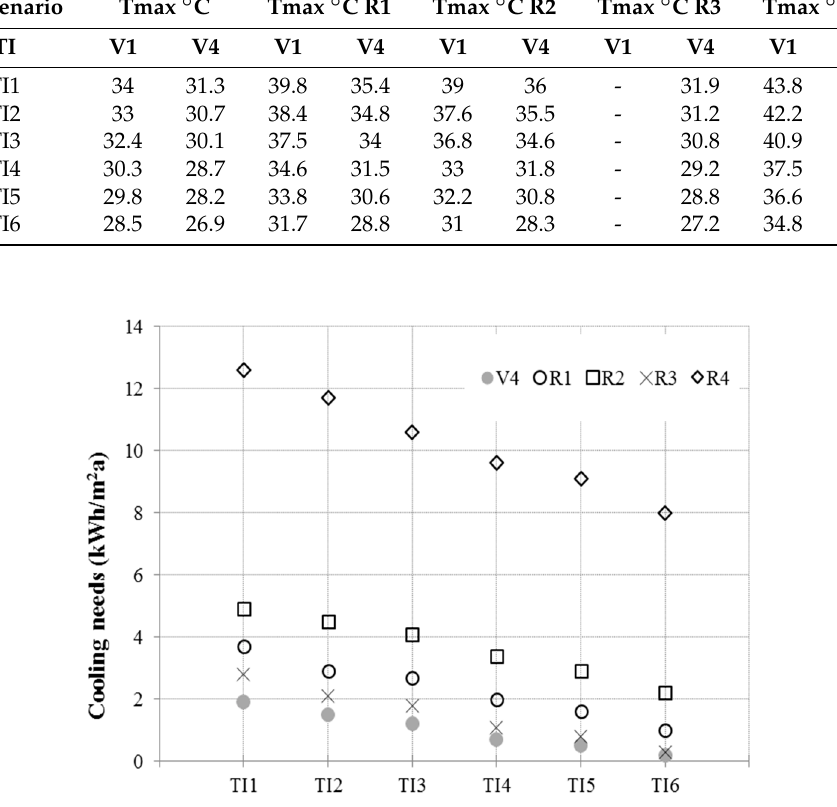
Figure 3. Cooling needs calculated for the combined scenarios: V4 and risk factors. TI effects ranges from 12% (R4) up to 62% (R3), considering the difference between TI1 and TI6.